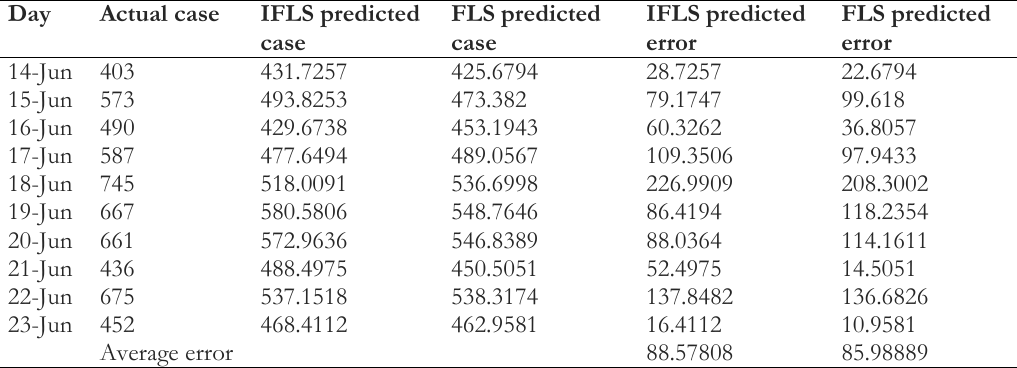
Table 2. Comparison of actual and predicted COVID-19 daily cases using IFLS and traditional type-1 FLS.